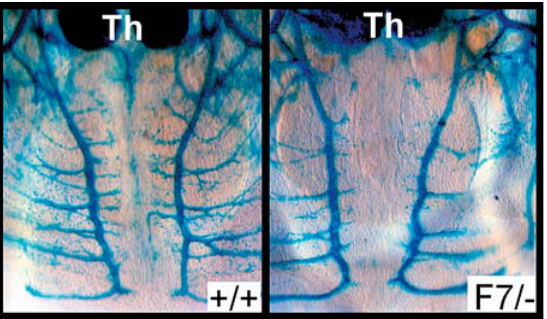
Figure 4. Reduction in V/P Cells in the Thoracic Region of E14.5 Embryos Ventral view of E14.5 wild-type and F7/ (cid:1) littermates with the XlacZ4 mouse marker background. b -Galactosidase-positive nuclei represent v/p cells. Th, thymus. DOI: